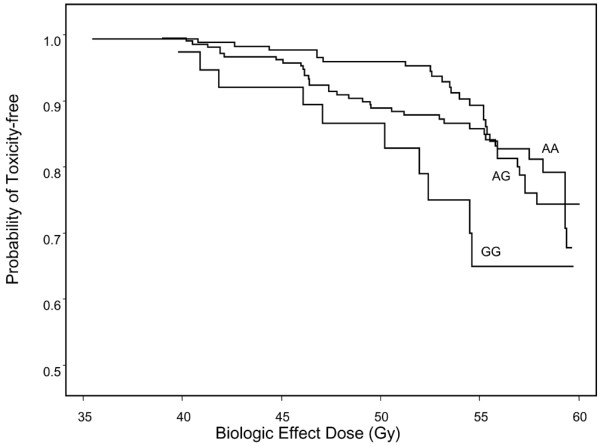
Probability of toxicity-free effects. Kaplan-Meier curve for the probability of toxicity-free effects (without Common Toxicity Criteria grade 2c toxicity or greater) by GSTP1 genotypes.